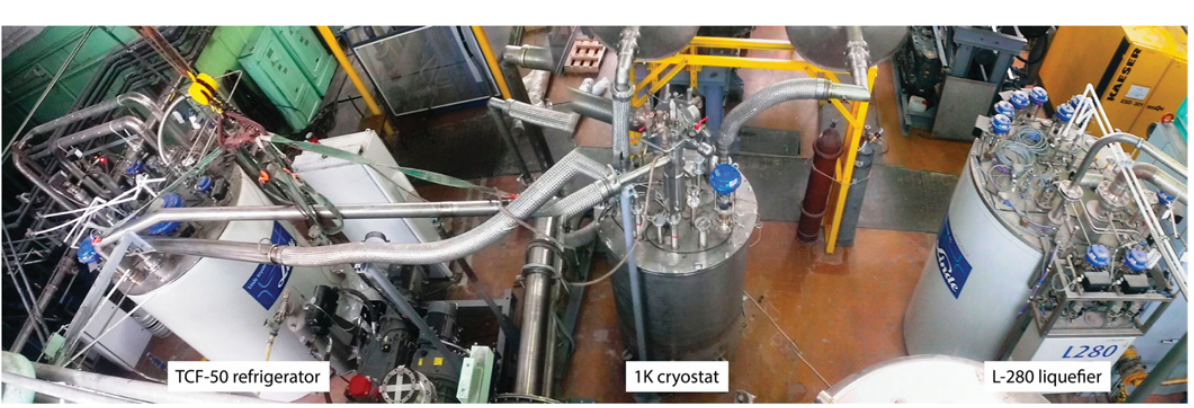
Figure 4. Photograph of the full-scale model of the UCN source for the WWR-M